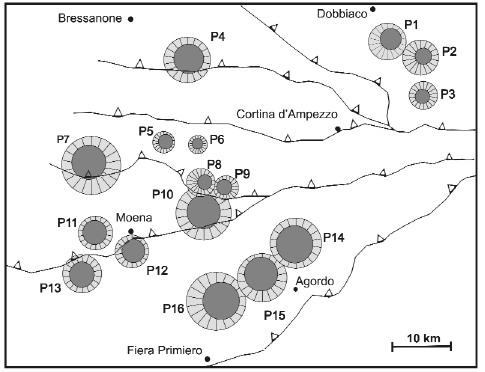
Fig. 4. The present-day distribution of the Late Anisian-Early Ladinian carbonate platforms consid- ered for modelling in the present note. The filled cir- cles tentatively represent the size of the initial nuclei, while the external circles (radial pattern) are propor- tional to the final size (maximum progradation). The general geometry of the bodies is obviously highly simplified. Platform labels indicated in figure corre- spond to table II. Major thrusts affecting the region are also